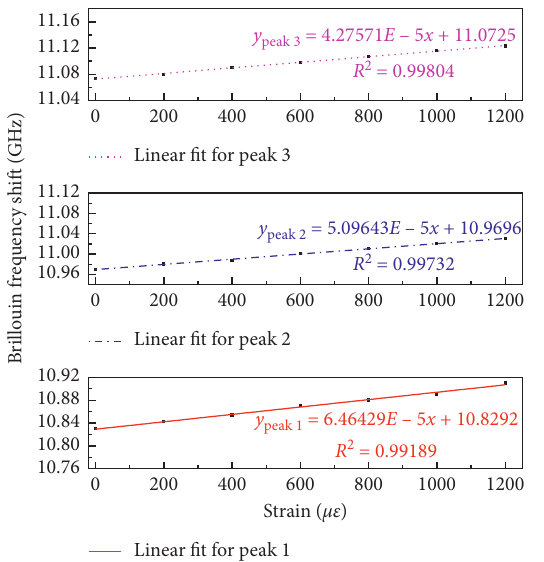
Figure 5: Measured BFS as a function of strain for peak 1, peak 2, and peak 3,